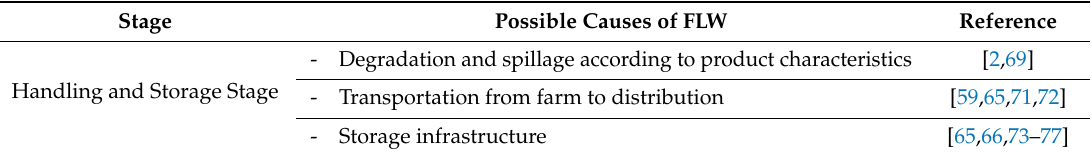
Table 7. Possible causes of FLW at the Handling and Storage stage of the FSC.